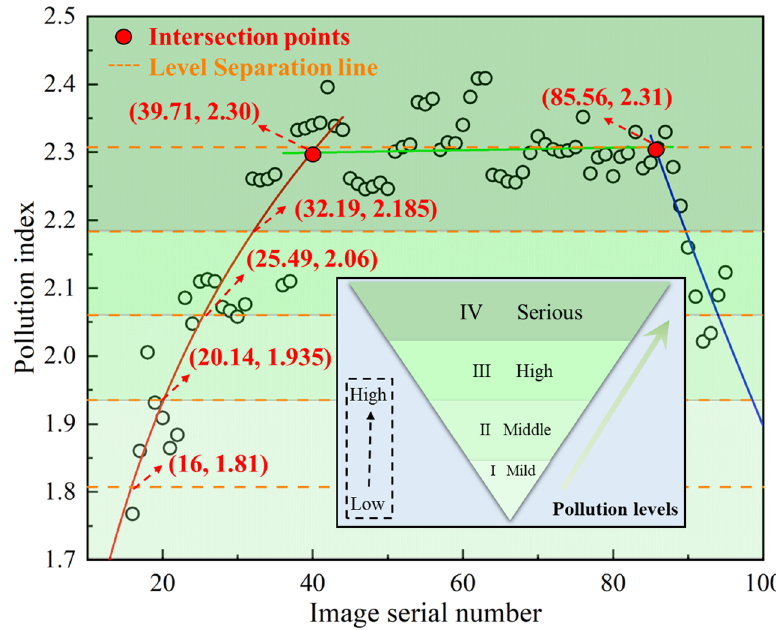
Figure 9. Four-level divisions of smoke dust pollution within the fitting plot, including a pollution level-pyramid graph representing the pollution